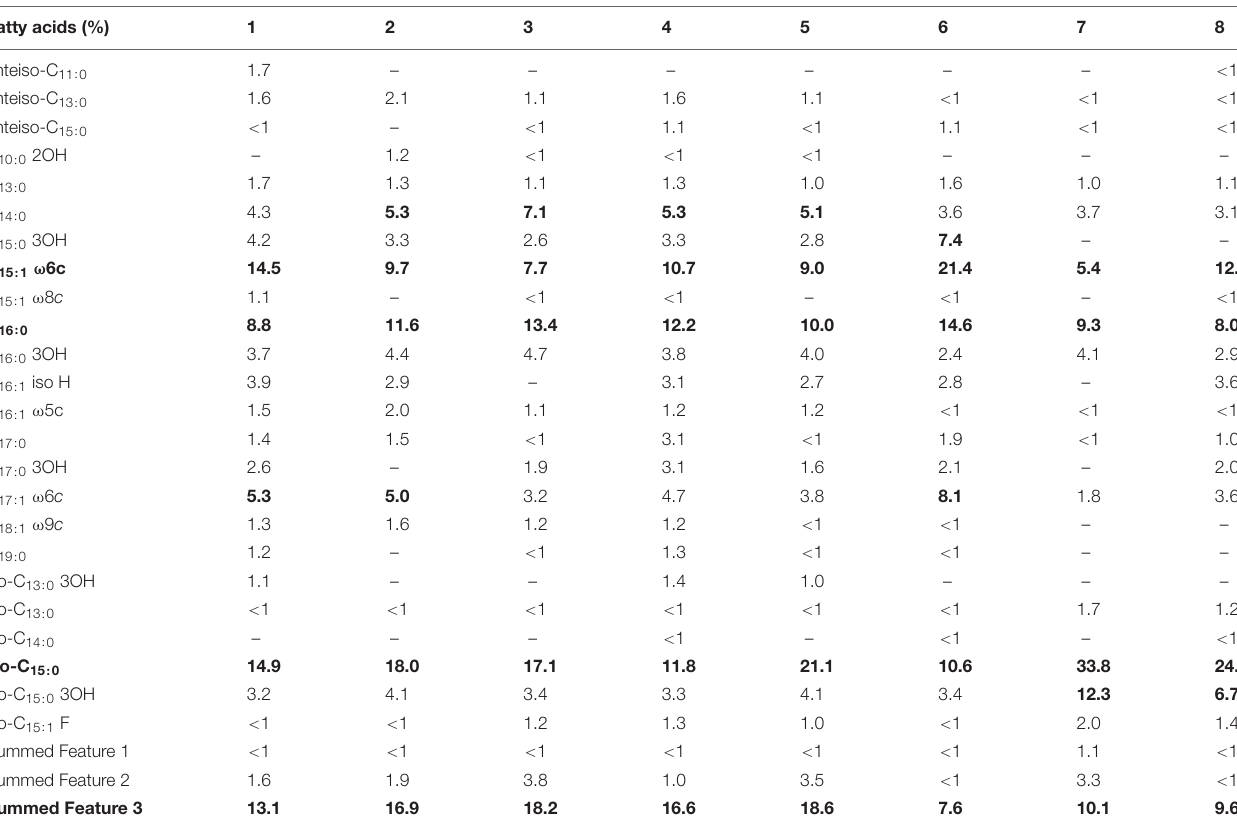
TABLE 2 | Fatty acid profile of isolated five strains and closely related species of the genus